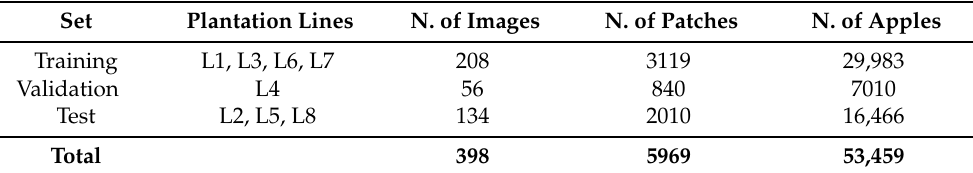
Table 2. Plantation lines in the training, validation and test set.